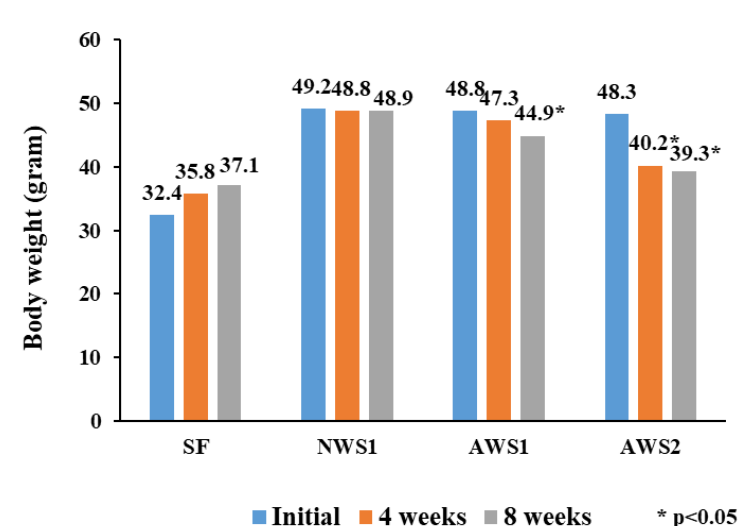
FIGURE 2 - Bodyweights of four experimental mice groups after 8